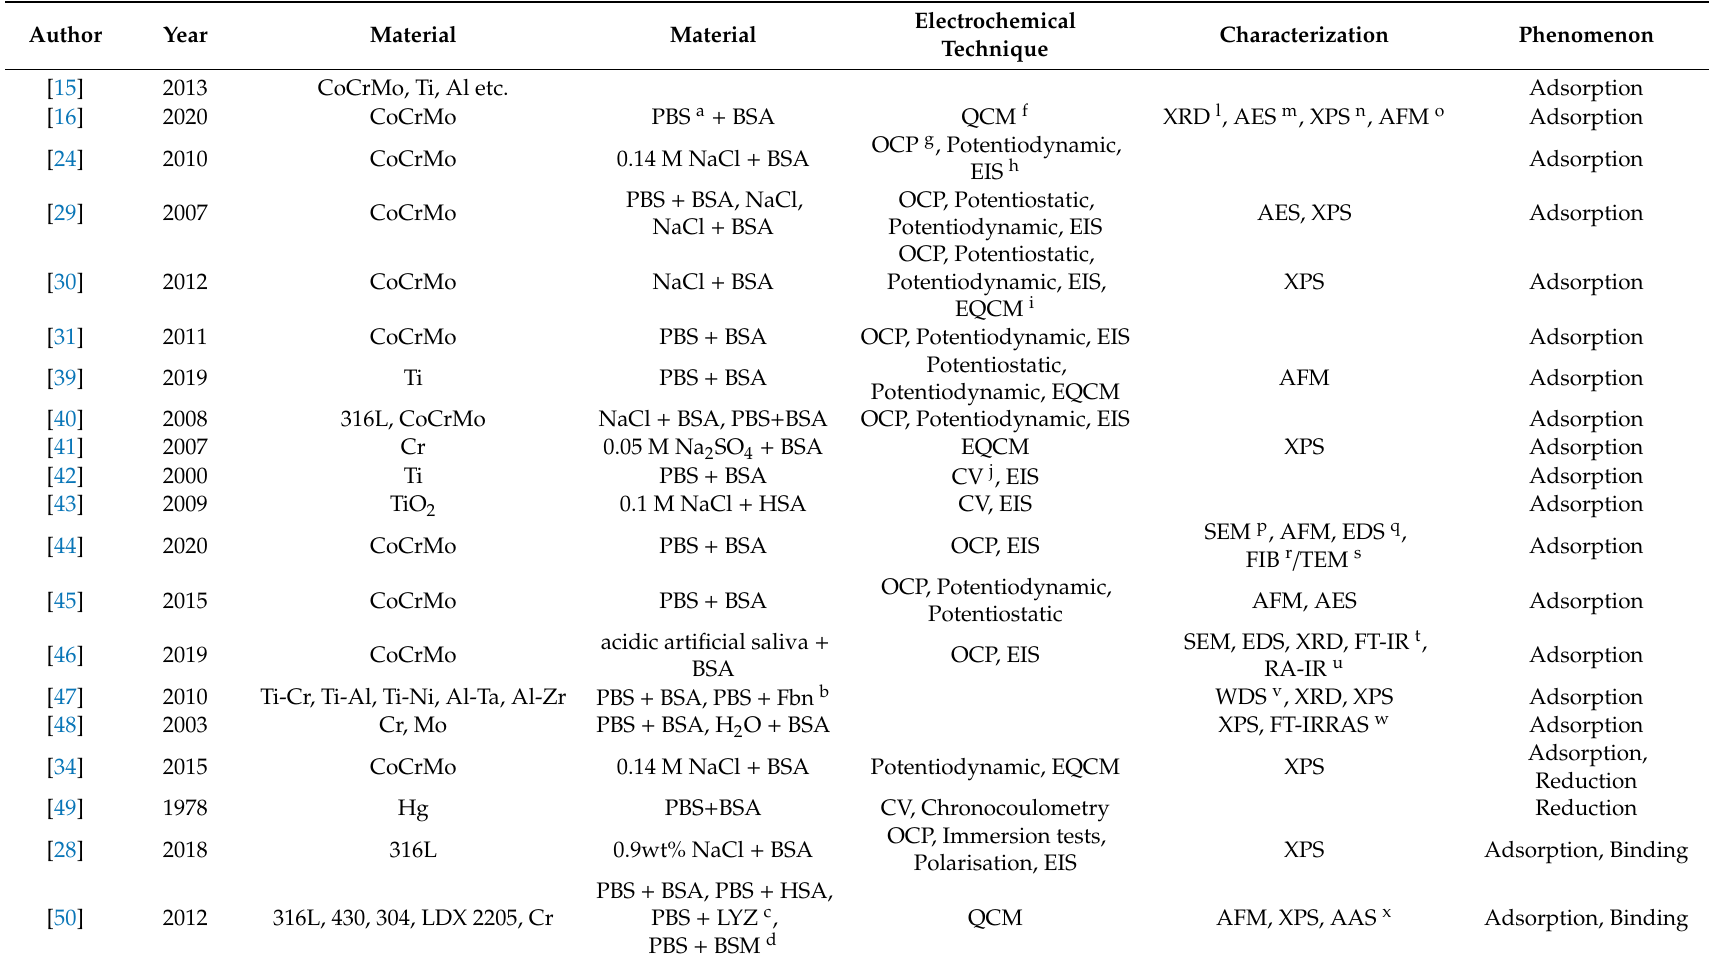
Table 1. Summary of the published papers containing mechanistic studies on the interaction of serum albumin with biomedical